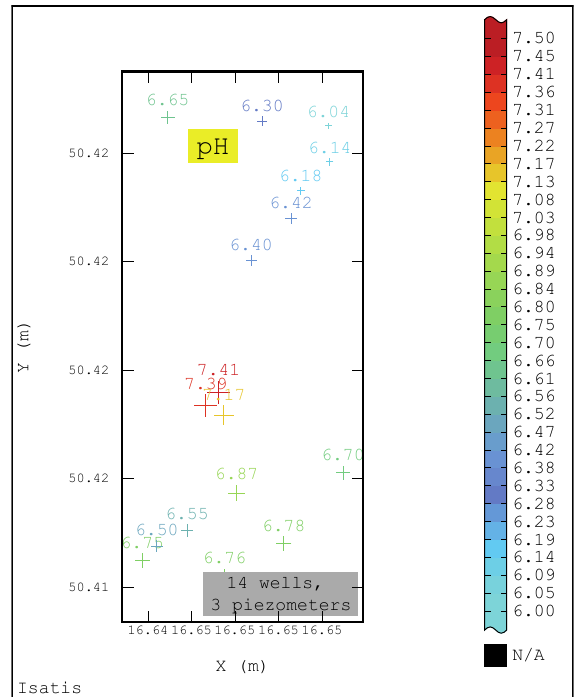
Fig. 2c. Base map of oxidation-reduction potential pH in underground water for water intake area of Kłodzko (SW part of Poland); data coming from 14 wells + 3 piezometers